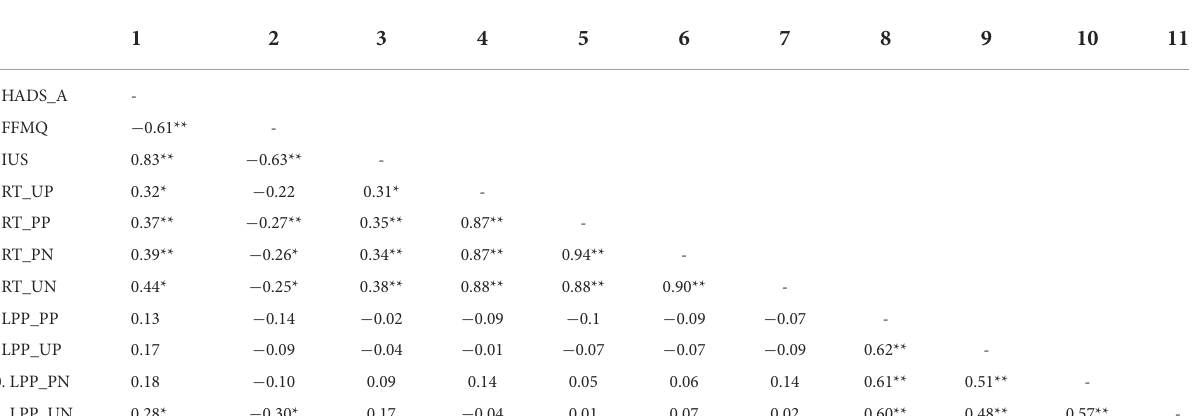
TABLE 5 Correlations between all variables.